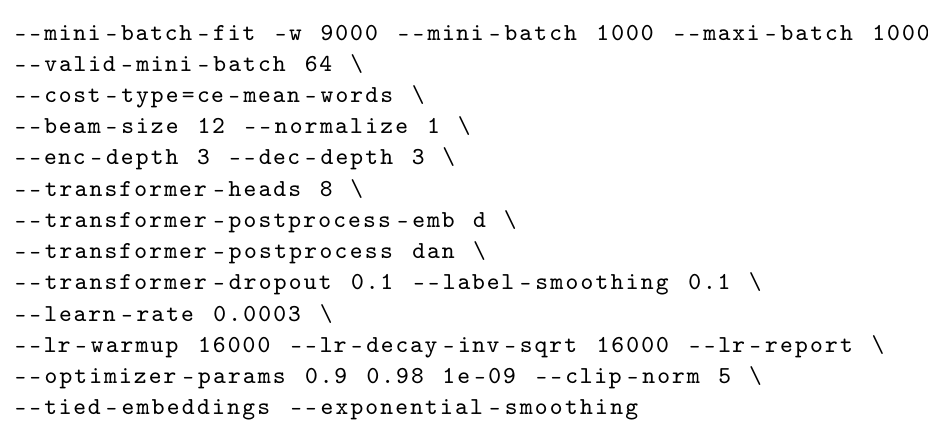
Table 2. Comparison of baseline, teacher and student models. (KD is the knowledge-distilled training